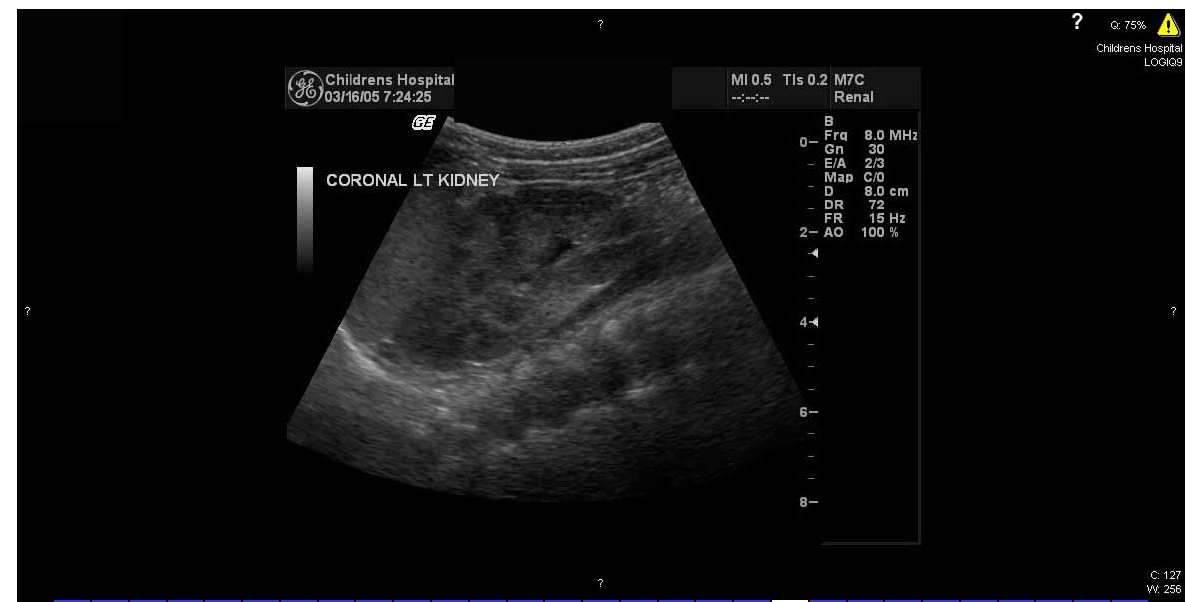
FIGURE 4A . Ultrasound demonstrating renal pelvis splitting (SFU grade